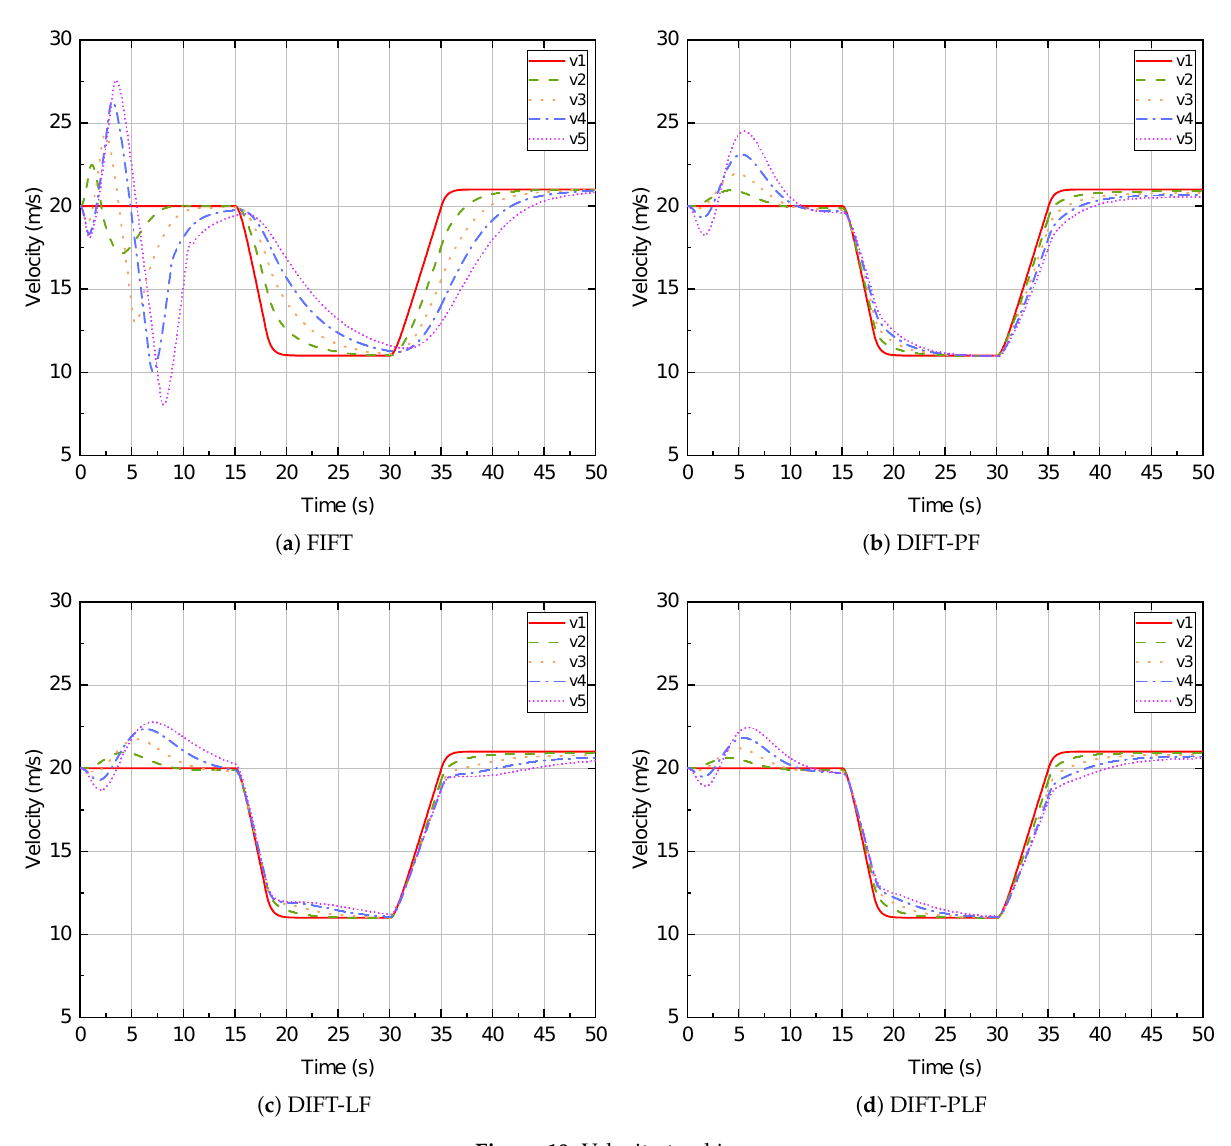
Figure 10. Velocity